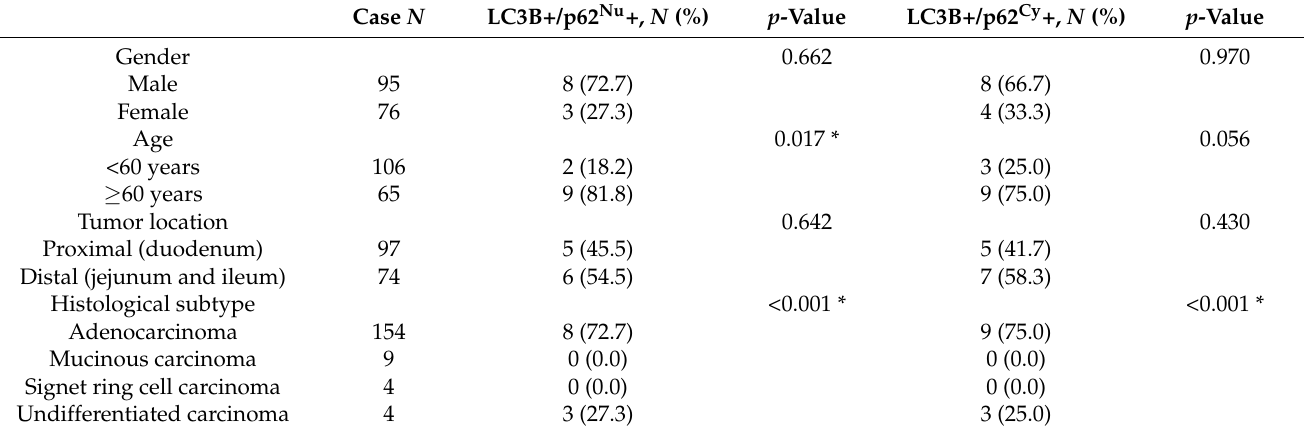
Table 4. The association between clinicopathologic features and combination of p62 and LC3B expression in patients with